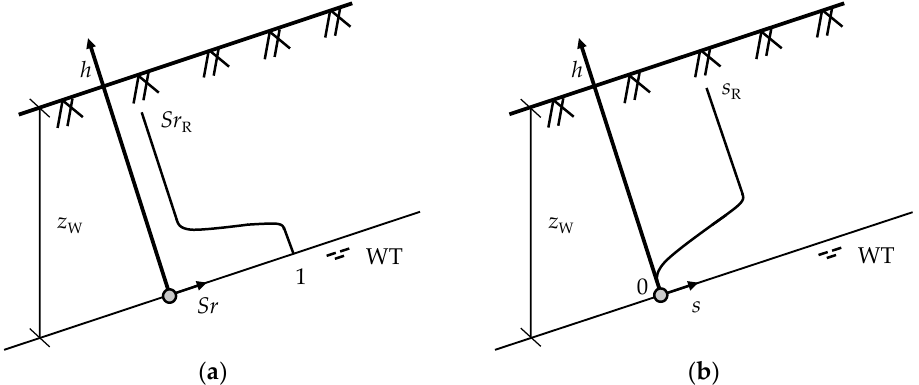
Figure 2. ( a ) Initial degree of saturation Sr profile; ( b ) Initial matric suction s profile, where h is the hydraulic head when the water table is located at a depth z W .